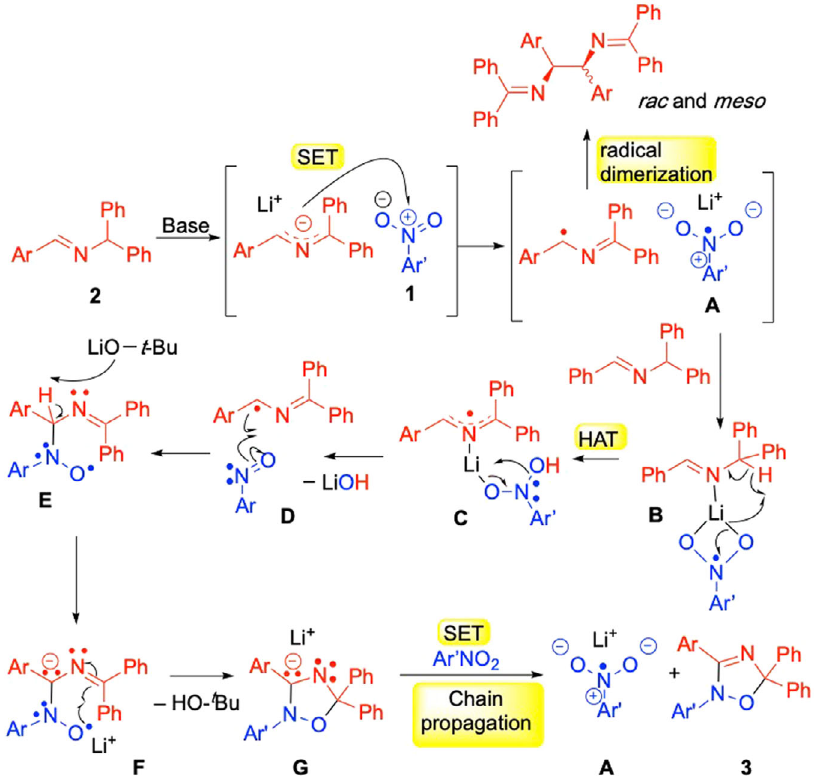
Fig. 9 Proposed reaction pathway. Key steps include reduction of the nitroarene by the 2-azaallyl anion, HAT from the aldimine to the nitroarene radical anion ( B ), formation of the nitrosoarene ( D ), and radical-chain propagation from G